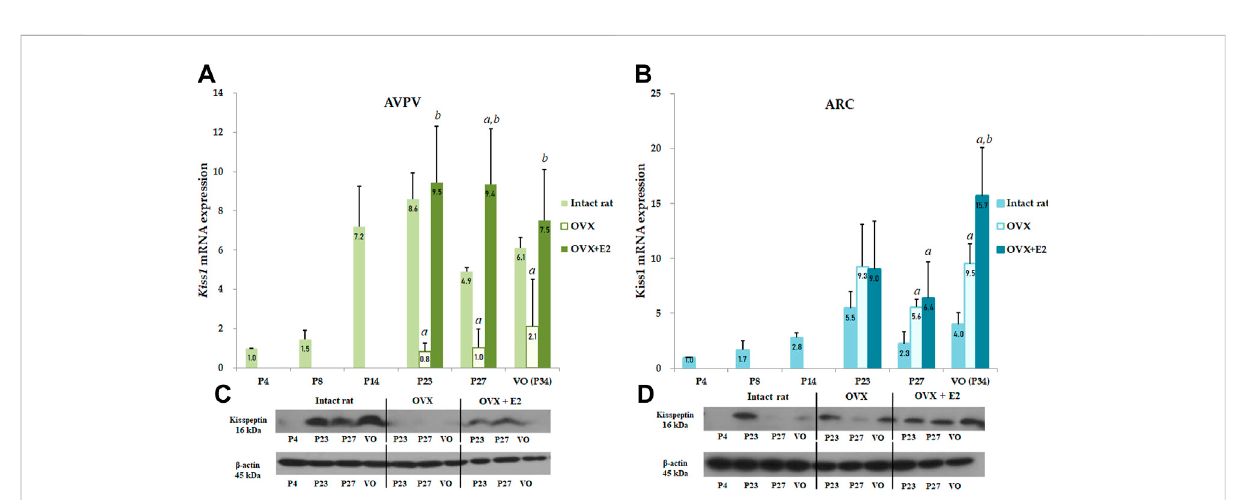
Developmental pro fi les of Kiss1 mRNA and protein expression in the anteroventral periventricular nucleus (AVPV) and arcuate nucleus (ARC) in intact female, ovariectomized (OVX), and estradiol-treated OVX rats (OVX + E2) from the neonatal stage to the onset of puberty. Ovariectomy was conducted on day 14,and specimens were collected on days 23, 27, and on the day of vaginal opening (VO) or day 34. Each group contained four to eight animals (A) Kiss1 mRNA expression of the AVPV was quanti fi ed by RT-qPCR. Each value was quanti fi ed on the basis of the value of Kiss1 mRNA expression in the AVPV on day 4. (B) Kiss1 mRNA expressionof theARC was quanti fi ed by RT-qPCR. Each value was quanti fi ed on thebasis of the value of Kiss1 mRNA expression in the ARC on day 4. (C) Kiss1 protein levels in the AVPV were quanti fi ed by western immunoblotting. (D) Kiss1 protein levels in the ARC were quanti fi ed by western immunoblotting. Each group contained four to eight animals. RT-qPCR analyses and western immunoblotting analyses wereperformed in triplicate. Data are presented as the mean ± standard error of themean. a Signi fi cant difference ( p < 0.05) in levels compared to those in intact female rats; b Signi fi cant difference ( p < 0.05) in levels compared to those in OVX